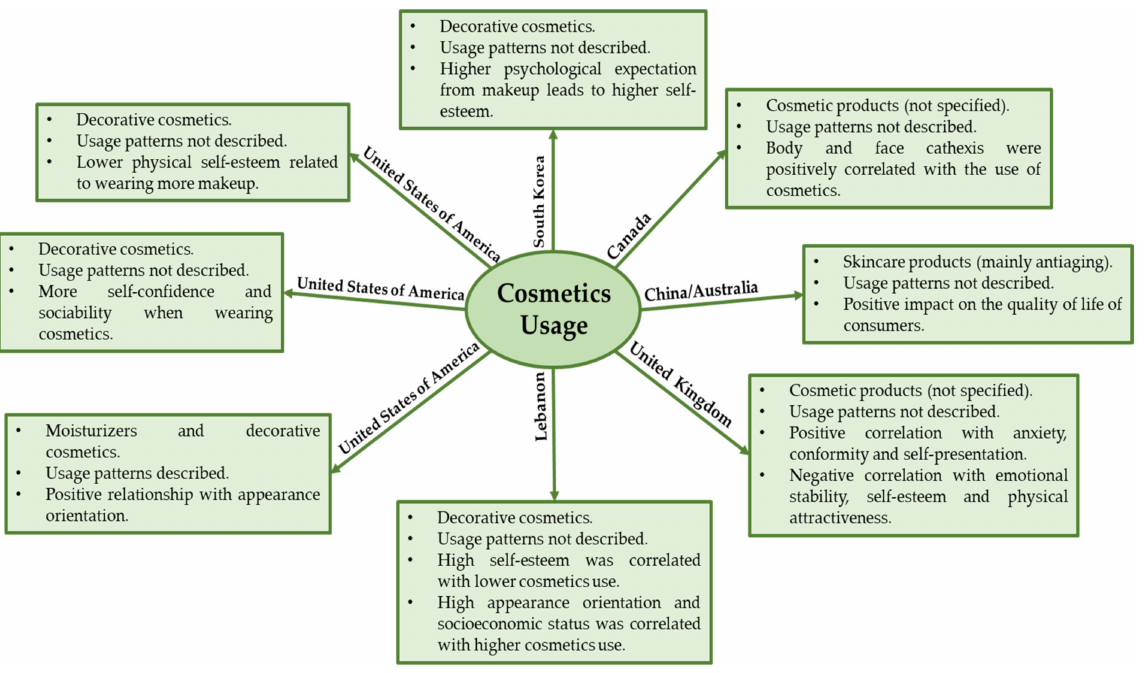
Figure 1. Relationship between the use of cosmetics and psychological variables